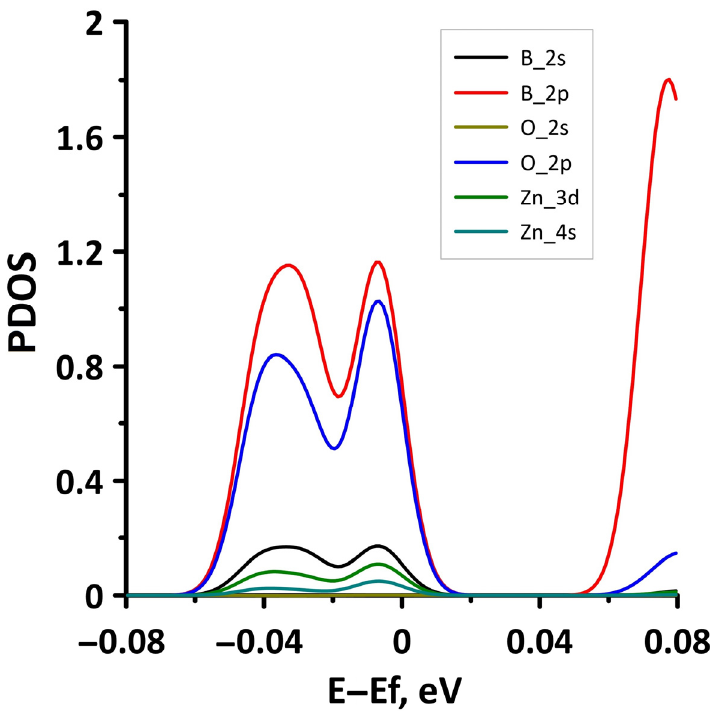
Figure 27. Fragments of PDOS near the Fermi level (shifted to 0 eV) of borophene/ZnO heterostruc- ture under biaxial stretching by 2%.